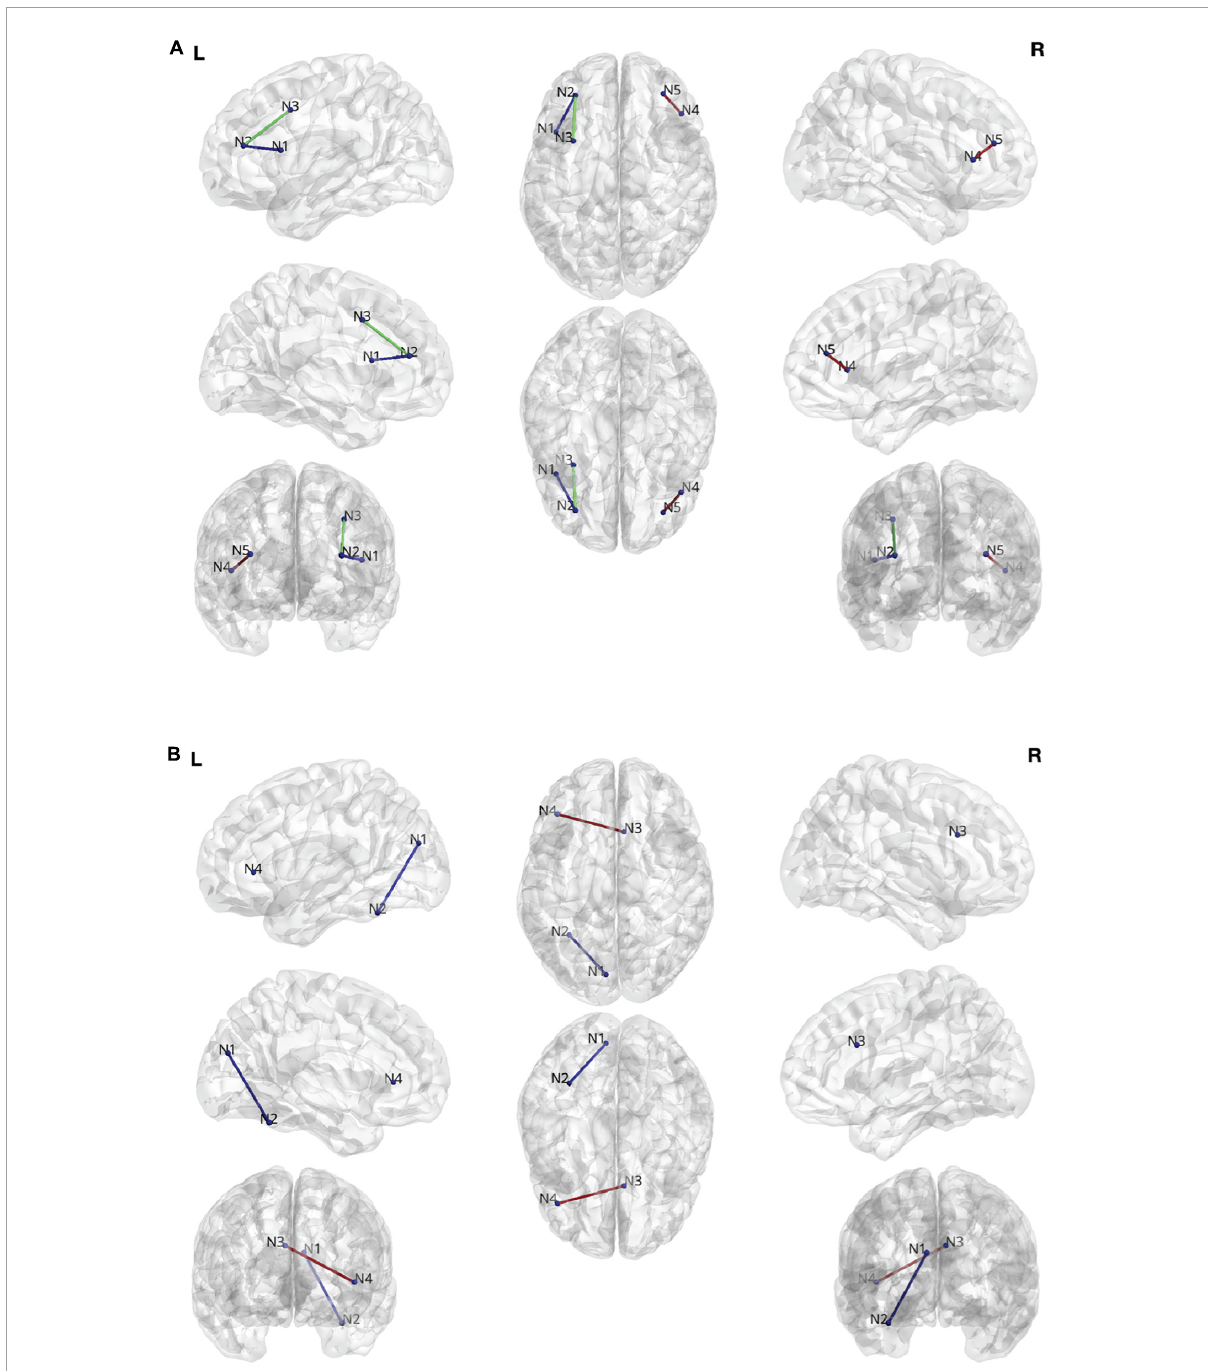
FIGURE3 (A) Edges found during the streamline analysis. N1: Left Inferior Frontal Gyrus (IFG)—pars opercularis. N2: Left rostral middle frontal gyrus. N3. Left caudal middle frontal gyrus. N4. Right IFG—pars triangularis. N5. Rostral middle frontal gyrus. (B) Edges found during the Ollivier-Ricci curvature (ORC) analysis. N1: Left cuneus cortex. N2: Left fusiform gyrus. N3: Right caudal anterior cingulate cortex. N4: Left IFG—pars triangularis.